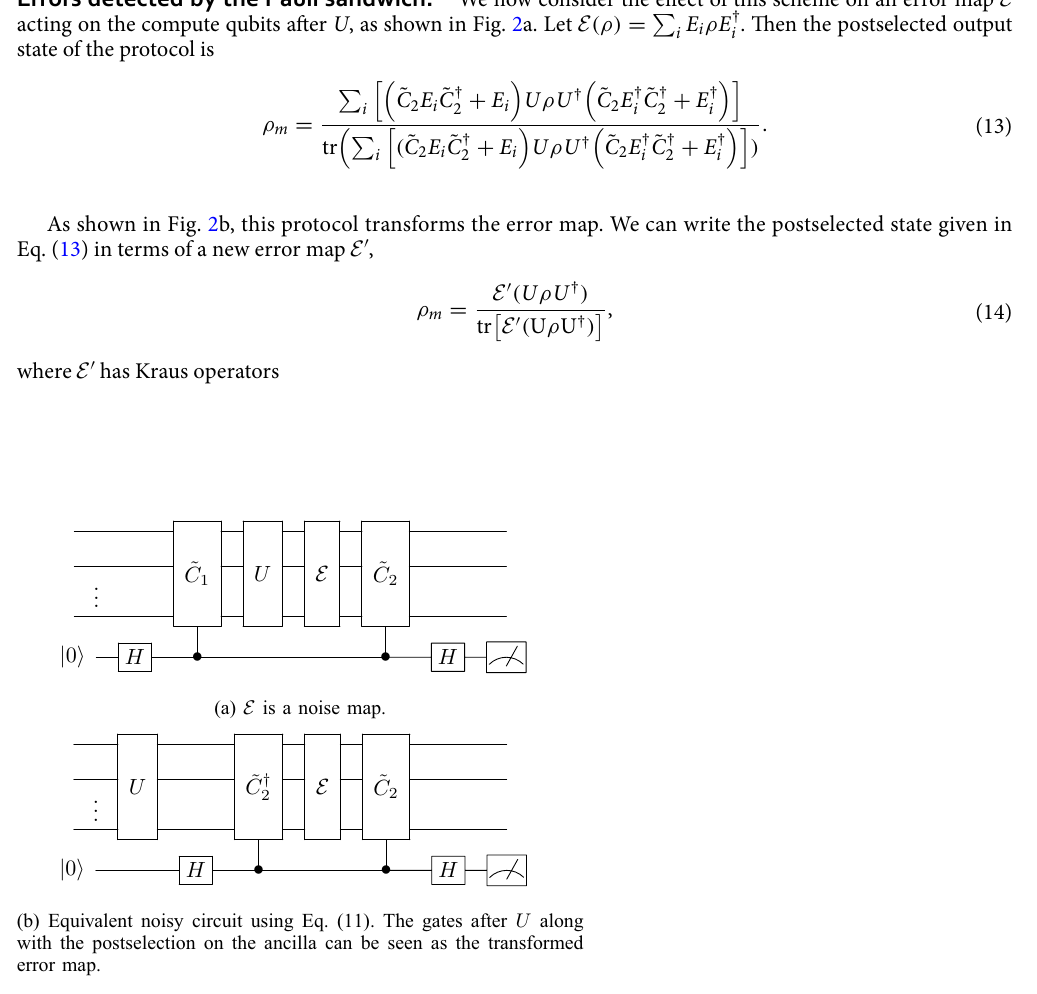
Figure 2. Noisy single-layer